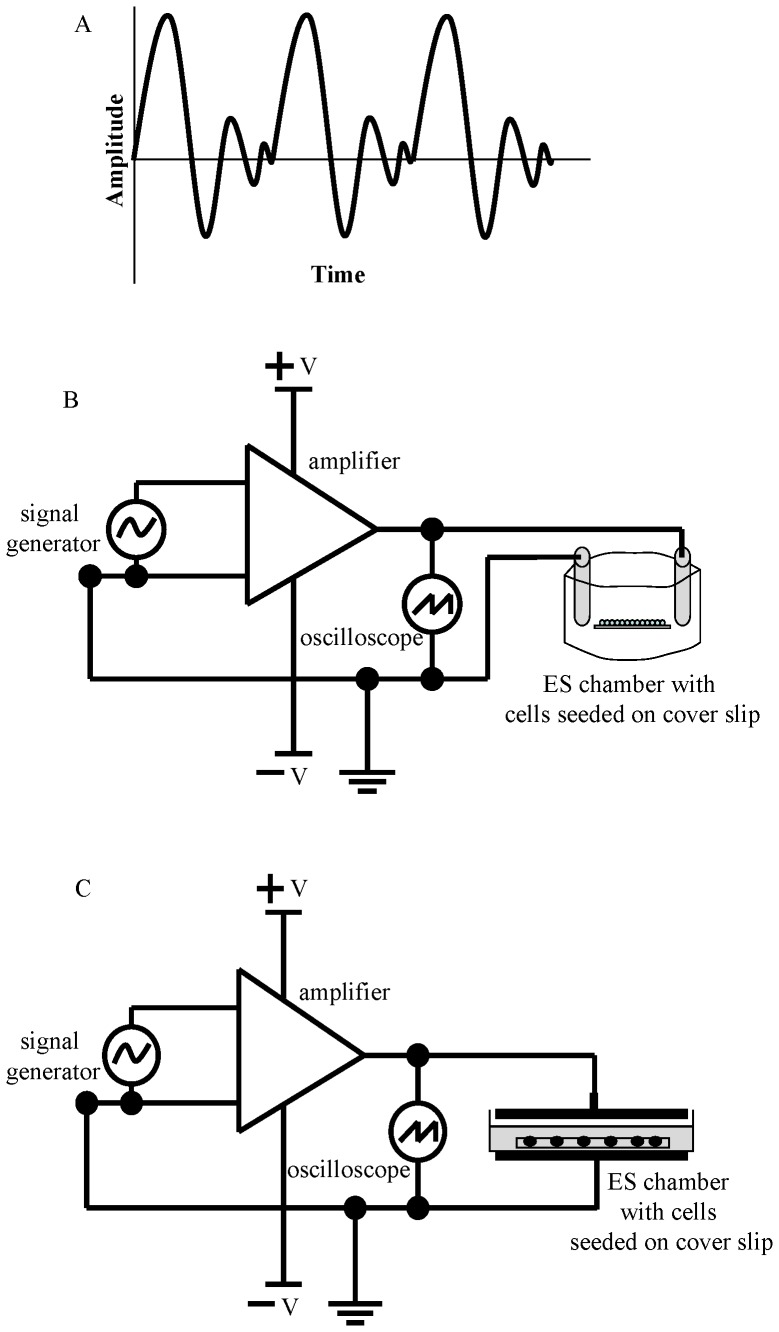
Degenerate waveform (1A) when applied to the customized in vitro ES apparatus with ES chamber (1B) or Capacitive Coupling stimulation apparatus (1C).